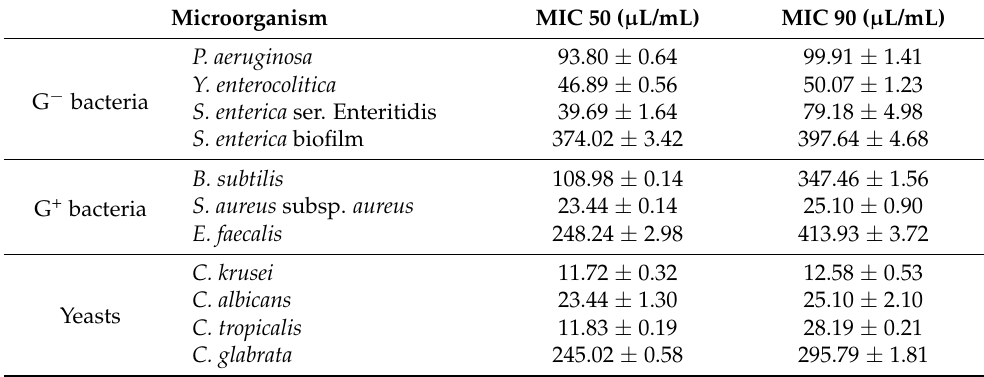
Table 5. Minimum inhibitory concentration of FEO against microorganisms.